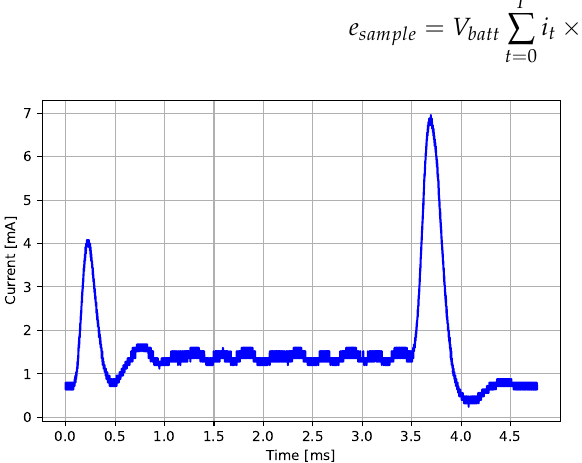
Figure 6. Current consumption profile of an MCU ECG sampling event.